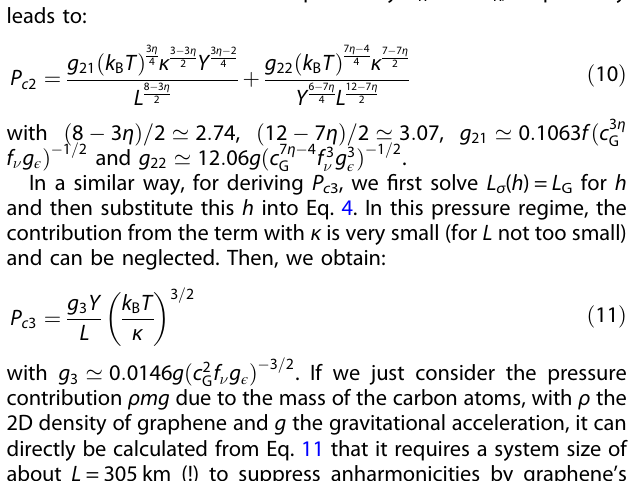
Bh 3 : 559 . In order to fi t our simulation data for pressures below